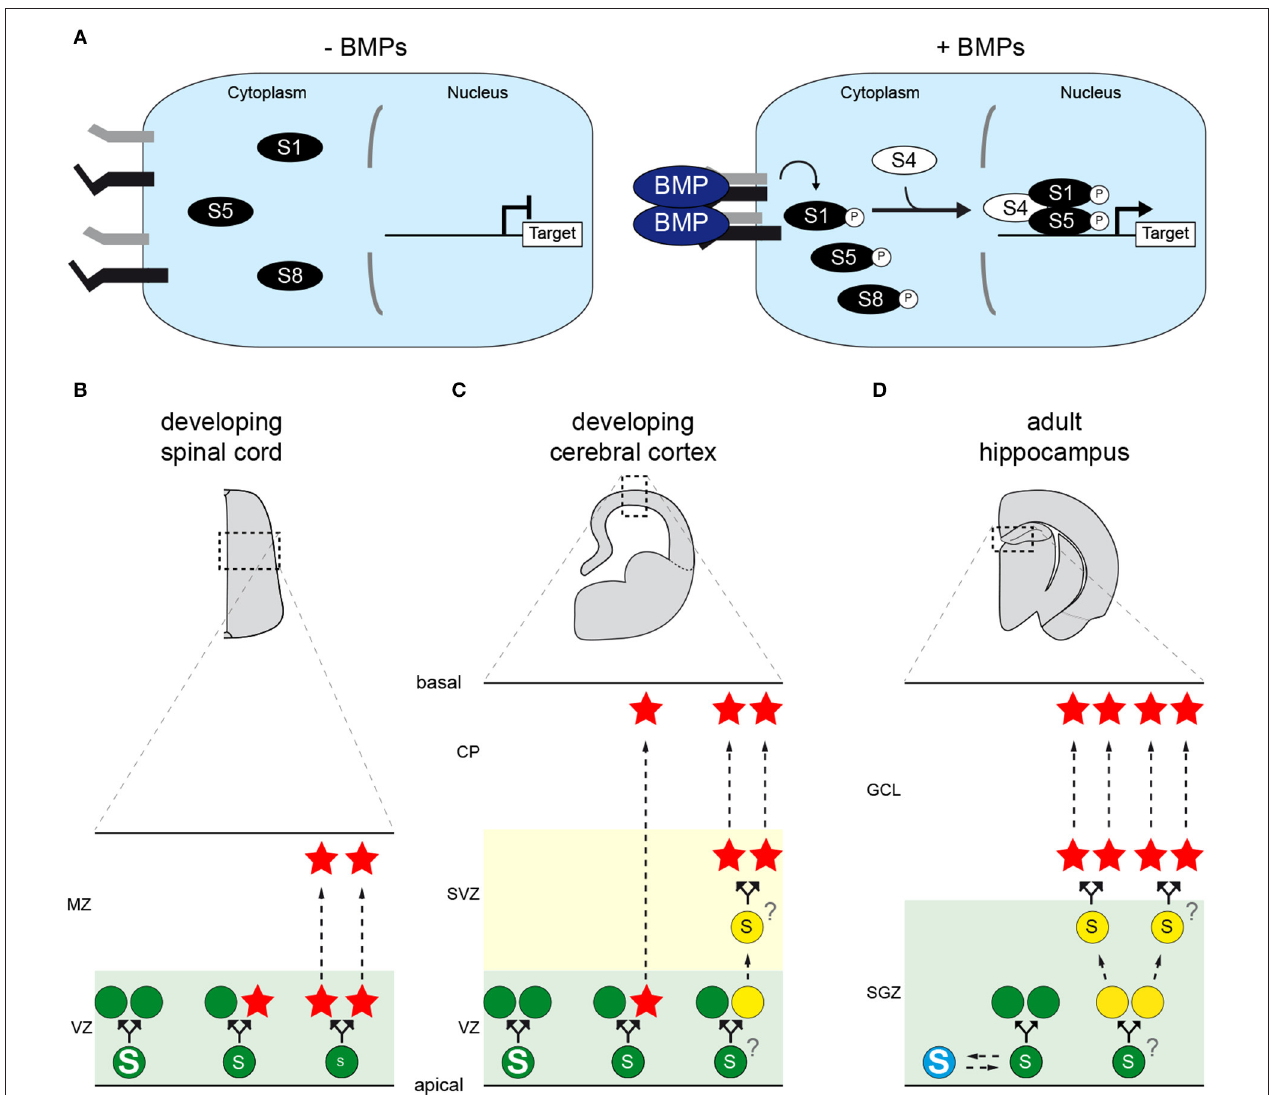
FIGURE 1 | The canonical BMP pathway and its role(s) during vertebrate CNS neurogenesis. (A) Representation of the canonical BMP pathway. Dimers of extracellular BMP ligands induce the formation of a tetrameric complex of transmembrane serine/threonine kinase receptors, in which constitutively active type-2 receptors (black) activate type-1 receptors (gray) through phosphorylation. Type-1 receptors in turn phosphorylate serine residues in the carboxy-terminal tail of SMAD transcription factors (SMAD1, SMAD5 or SMAD8/9), enabling them to interact with their co-partner SMAD4. This activated SMAD complex thereby enters the nucleus, recruits co-factors and regulates the transcription of target genes, such as members of the ID family. The duration of exposure to BMPs and their concentration are therefore converted into different levels and/or durations of transcriptional activity. (B–D) The canonical BMP activity dictates neural stem cell (NSC) divisions during neurogenesis in the vertebrate CNS. (B) During spinal neurogenesis, high levels of SMAD1/5 activity instruct NSCs (green disks) located in the ventricular zone (VZ) to self-amplify, whereas low levels force NSCs to undergo self-consuming divisions, hence depleting their pool and producing neurons (red stars) that will delaminate and migrate toward the mantle zone (MZ). Intermediate levels are proposed to instruct self-renewing neurogenic divisions. (C) During cortical neurogenesis, high levels of SMAD1/5 activity stimulate NSC self-amplification, whereas lower SMAD1/5 levels force them to produce neurons that will migrate to the cortical plate (CP). In this region, neurogenesis can occur either directly or indirectly, the latter case giving rise to transit-amplifying basal progenitors (yellow disks) that undergo self-consuming divisions in the subventricular zone (SVZ). Whether the modes of direct and indirect neurogenesis are instructed by comparable or distinct thresholds of SMAD1/5 activity remains unknown. (D) In the adult mammalian hippocampus, NSCs located in the sub-granular zone (SGZ) of the dentate gyrus are instructed to remain quiescent (blue disk) in response to canonical BMP signaling. Reducing its activity forces the activation of NSCs, which might self-amplify for several rounds before undergoing self-consuming divisions that produce transit-amplifying progenitors. These in turn produce adult-born neurons that will populate the granule cell layer (GCL). Whether the distinct modes of division that activated NSCs undergo are instructed by comparable or distinct thresholds of SMAD1/5 activity remains